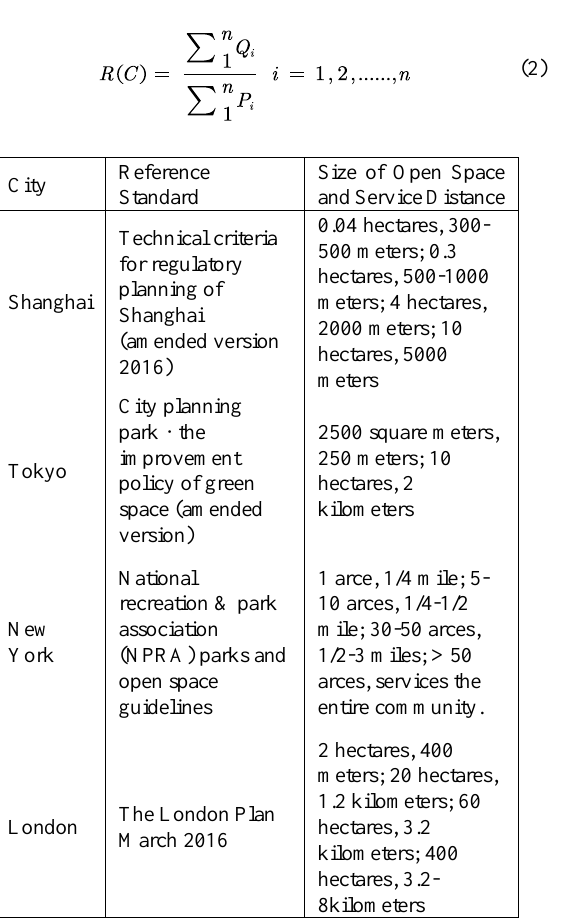
Table 3. The availability standards of the four cities